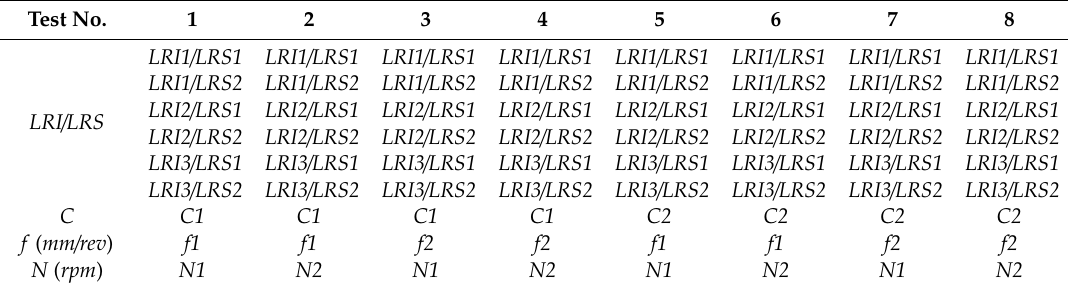
Table 2. Mg-Al-Mg specimen experimental design: product of a full factorial 2 3 and a block of two factors. Test No.